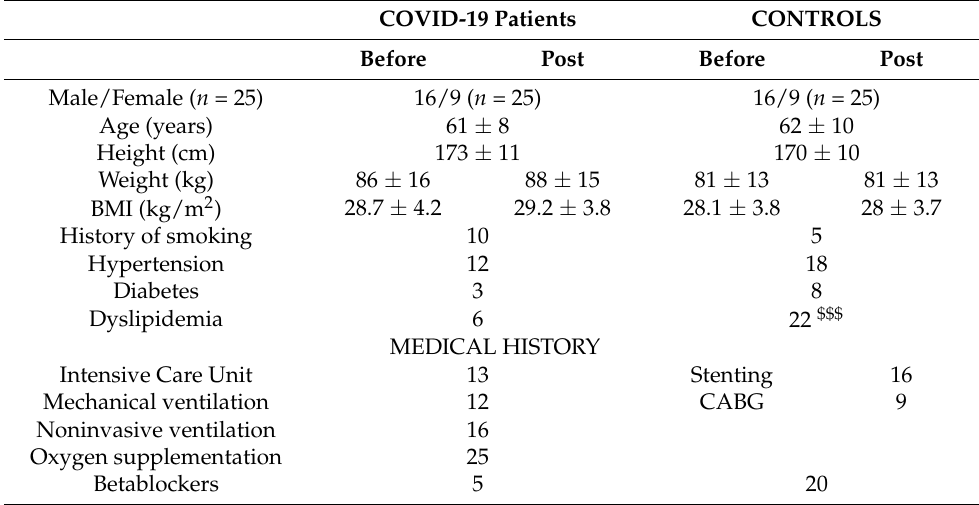
Table 1. Study population and its